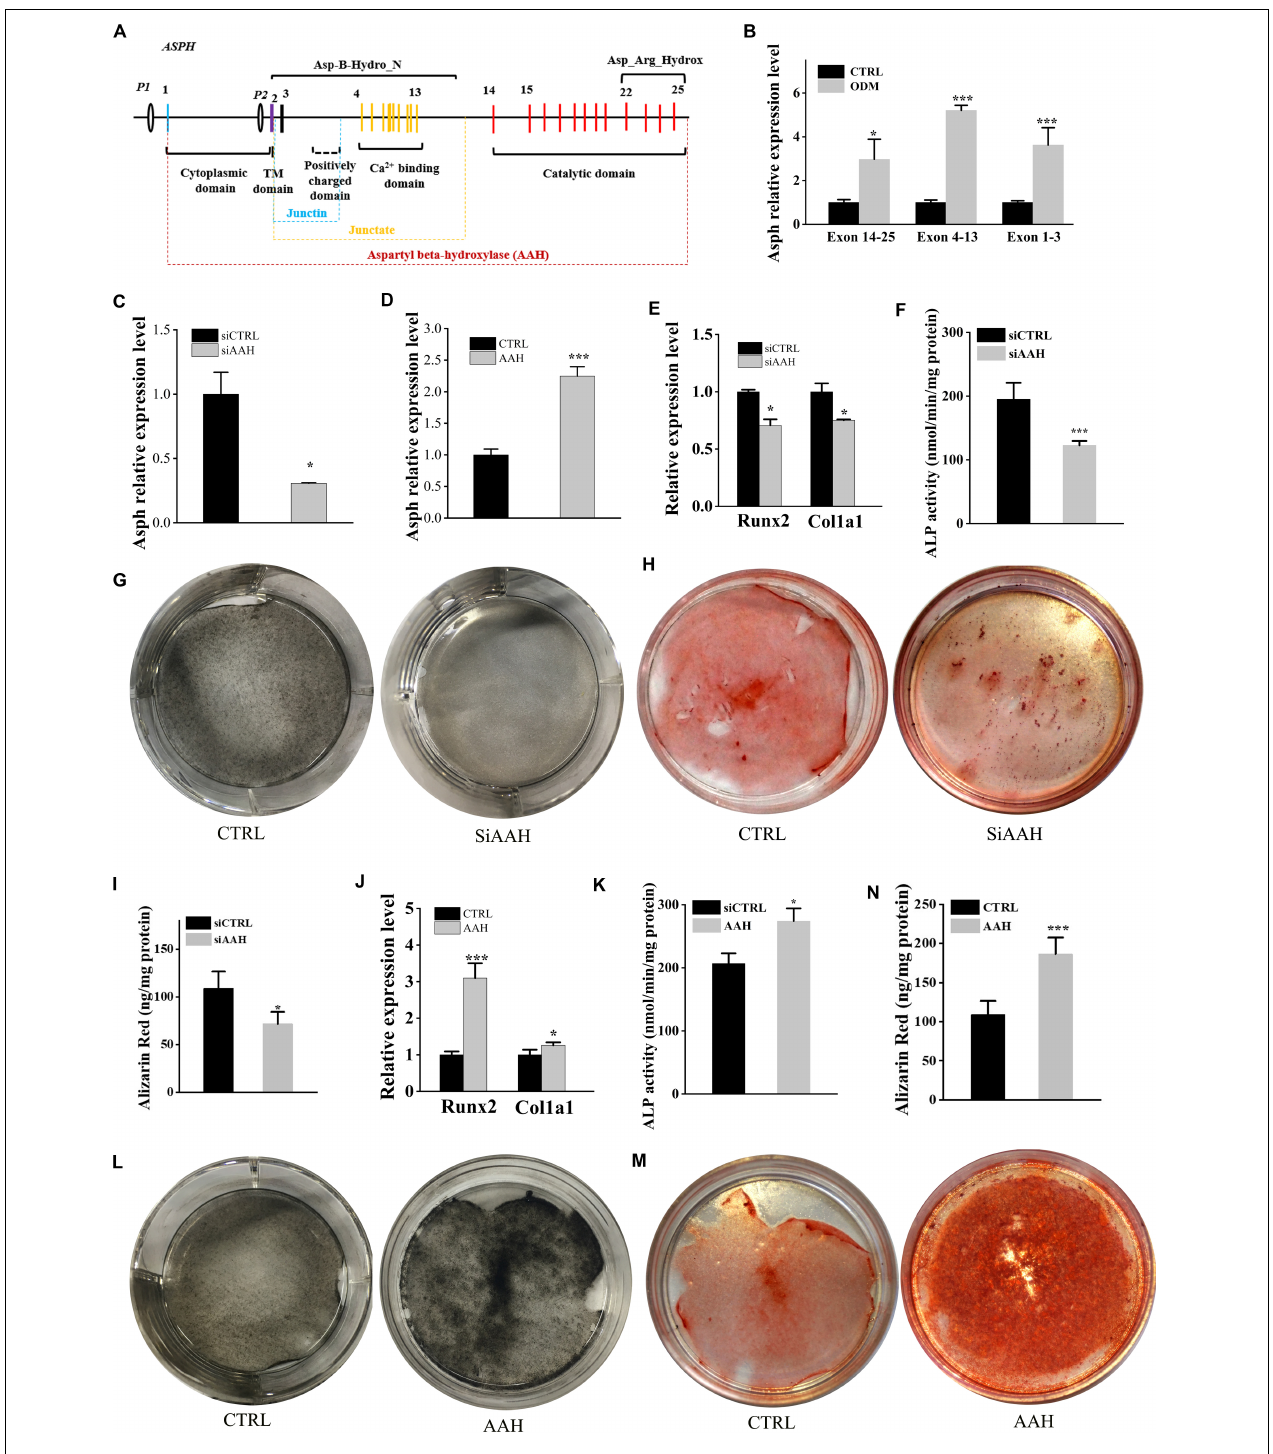
FIGURE 3 | ASPH promotes osteogenic differentiation. (A) schematic graph for ASPH isoforms. (B) qRT-PCR analysis of ASPH regions’ expression during osteogenic differentiation. (C) qRT-PCR analysis of depletion of AAH. (D) qRT-PCR analysis of overexpression of AAH. (E) qRT-PCR analysis of the relative levels of Runx2 and Col1a1 in BMSCs with depletion of AAH. (F) Analysis of ALP activity in BMSCs with depletion of AAH. (G,H) Representative images of ALkaline Phosphatase (ALP) staining (G) and Alizarin red S staining (H,I) in BMSCs with depletion of AAH. (J) qRT-PCR analysis of the relative levels of Runx2 and Col1a1 in BMSCs with overexpression of AAH. (K) Analysis of ALP activity in BMSCs with overexpression of AAH. (L,M) Representative images of ALP staining (L) and Alizarin Red S staining (M,N) in BMSCs with overexpression of AAH. These experiments were replicated three times. Error bars show standard deviation. * P < 0.05, *** P <